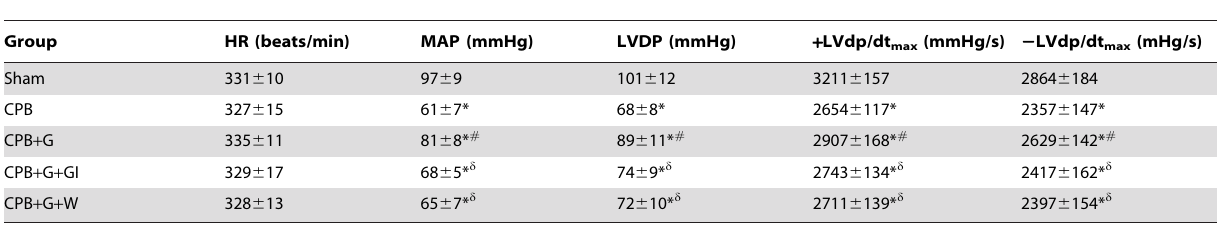
Table 1. Effects of ghrelin on cardiac function in different groups after CPB (n =8, mean 6 SEM).